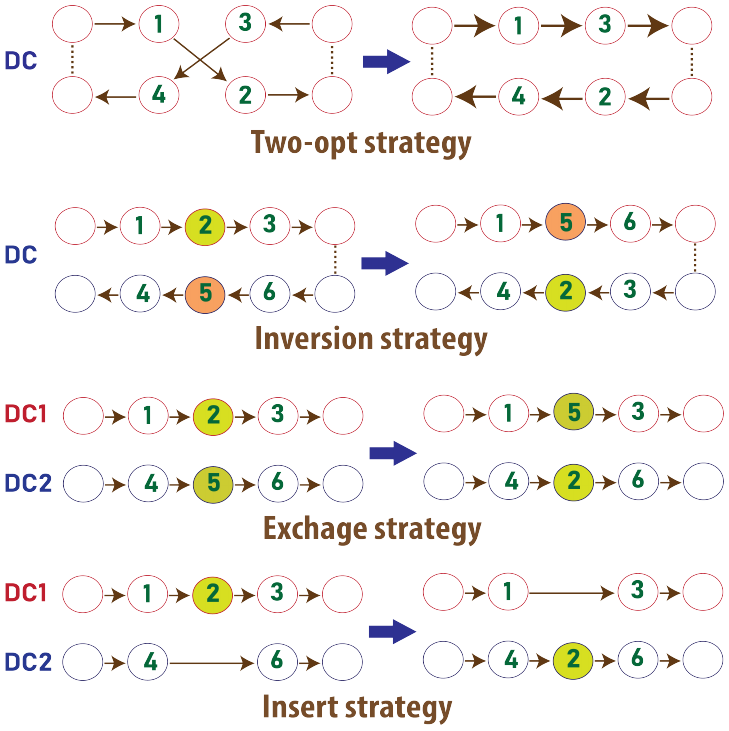
Figure 5. Local search